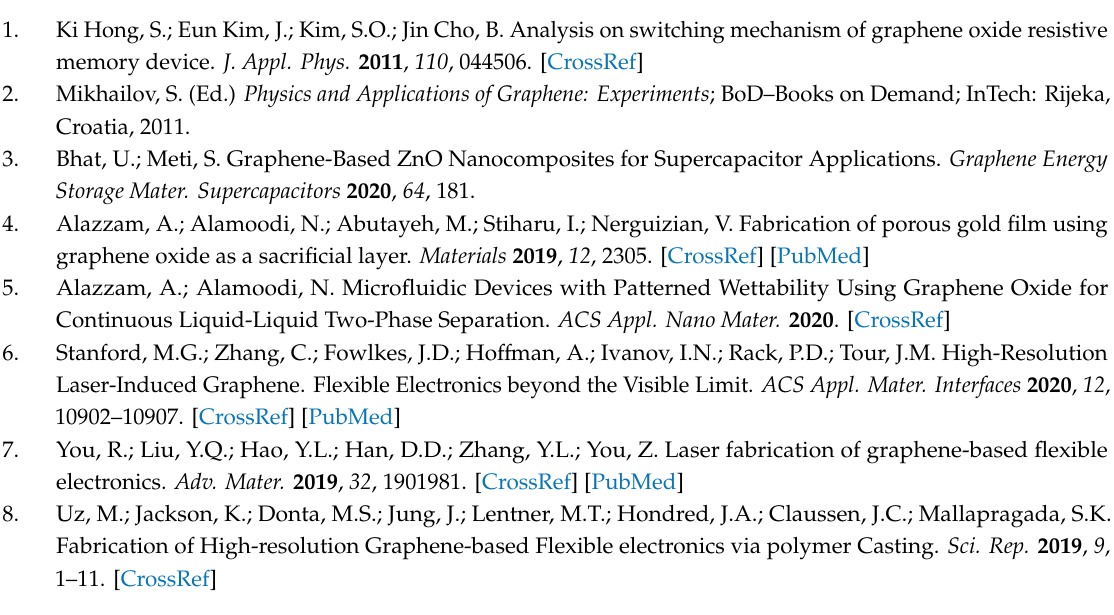
Figure 5. A microscopic image of pDEP response of RBCs under an AC signal of 5 Vpp at 1 MHz.